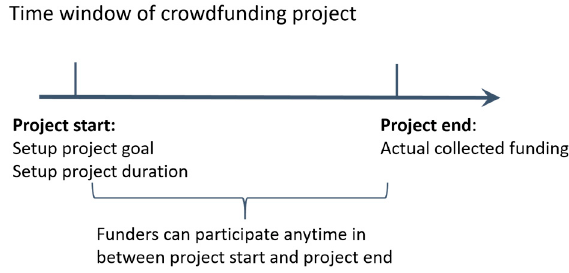
Figure 1. Time windows of crowdfunding project.